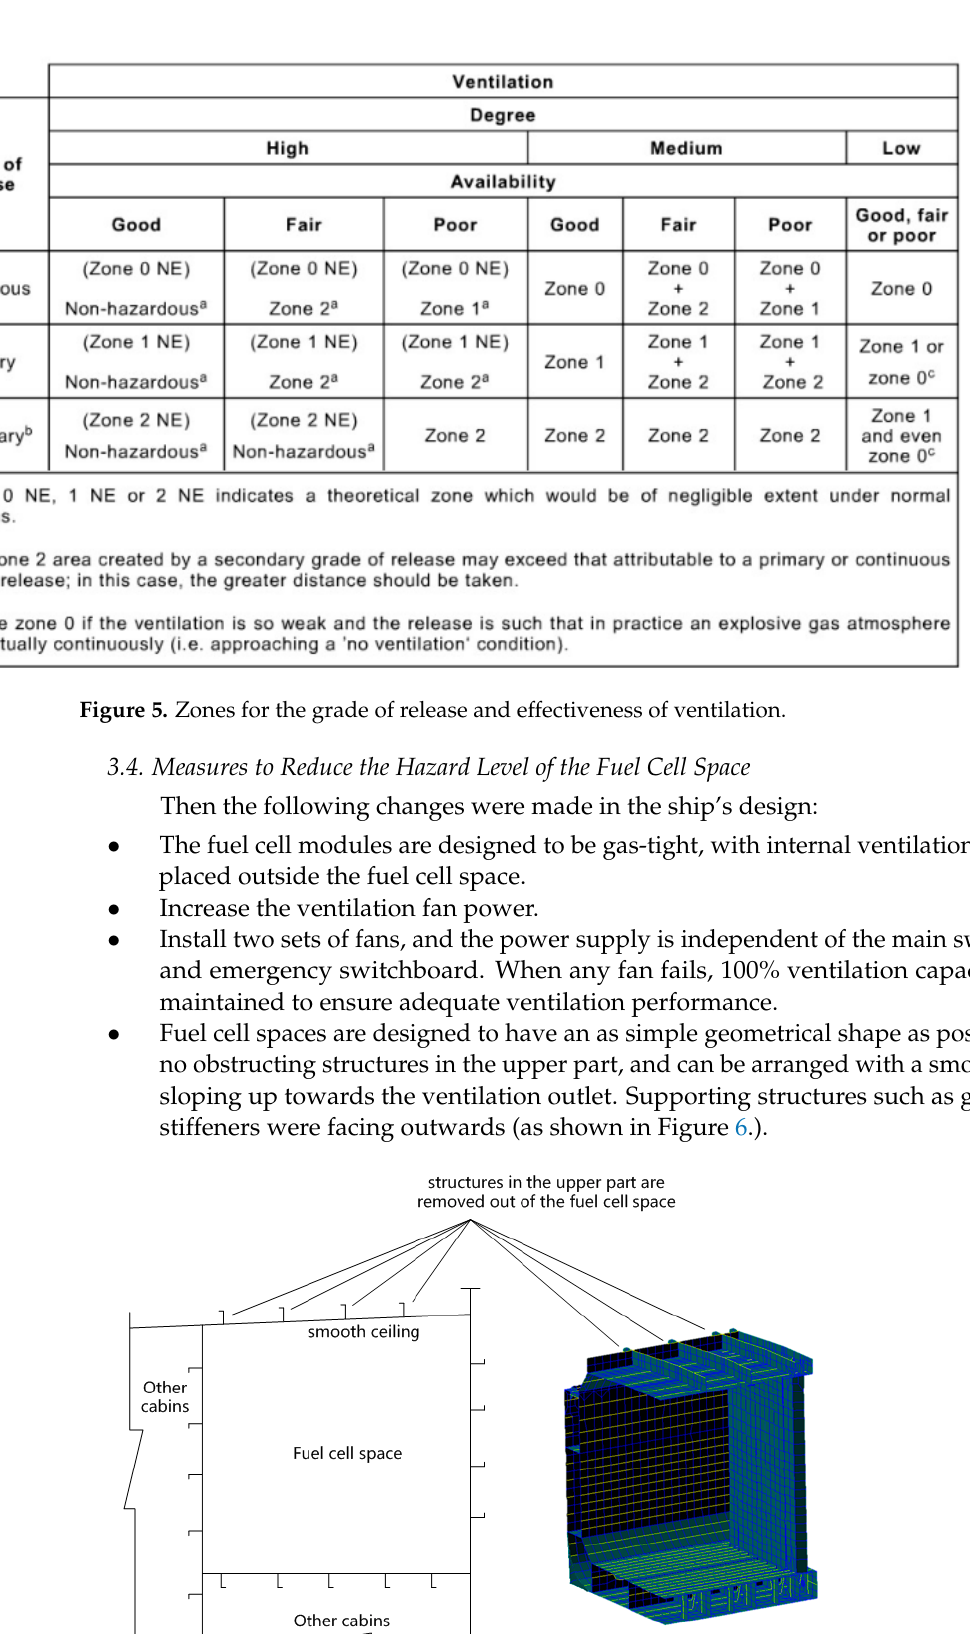
Figure 7. Schematic design of a double-wall piping system, air-tight gas valve unit, and gas-tight cover of the fuel cell. 4. Results IEC62282-2 states that when a fuel cell is placed in a gas-tight container, the gas leakage test is not required. Therefore, with the gas-tight cover, H 2 released in the fuel cell module will be quickly discharged through the internal ventilation and will not leak